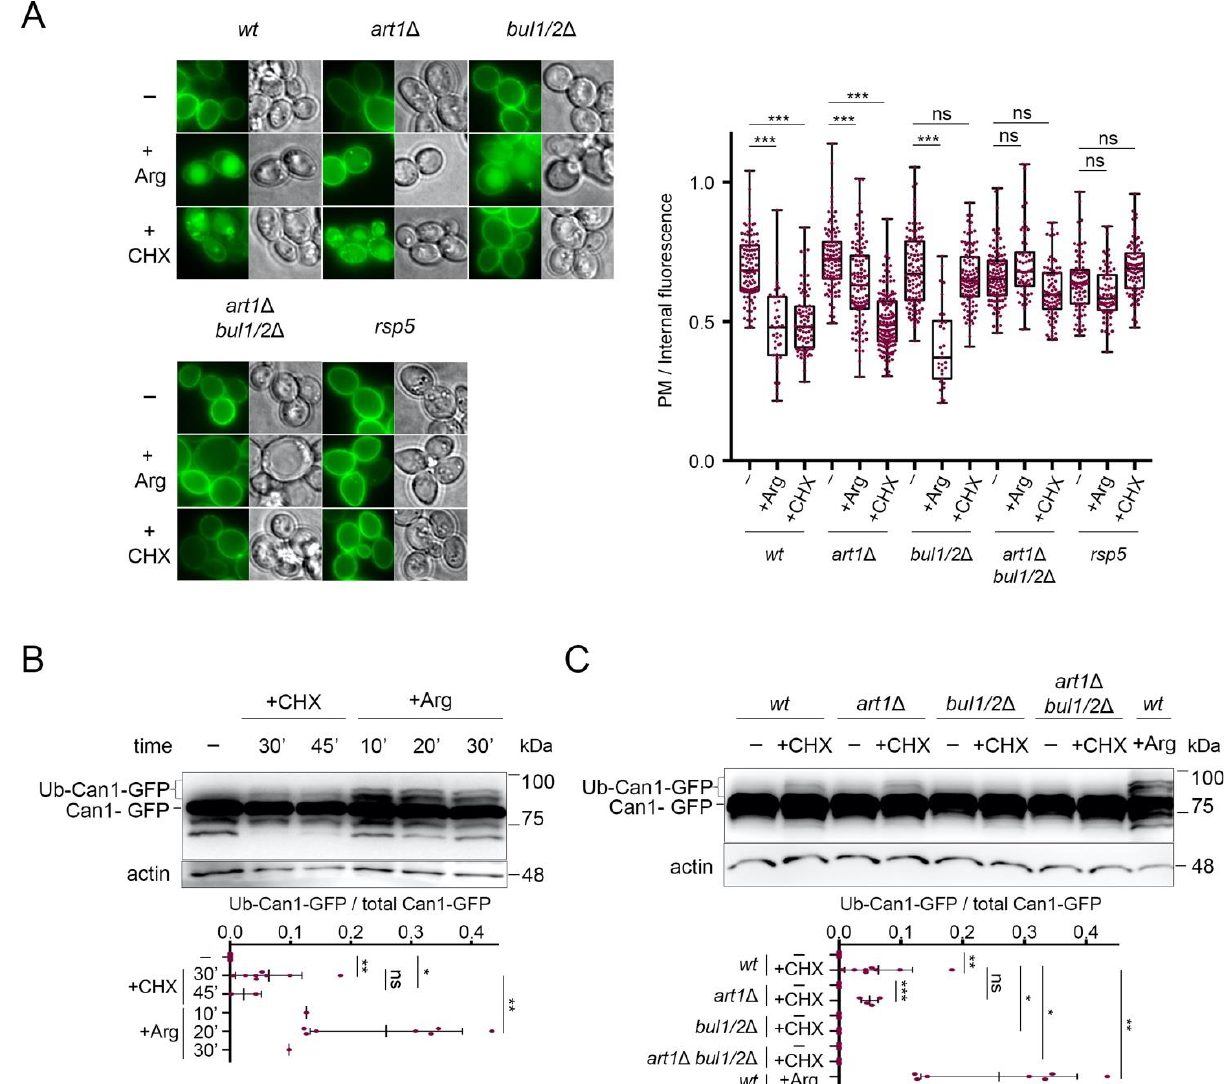
Figure 2. Can1 endocytosis in CHX-treated cells requires the Bul1/2 alpha-arrestins. ( A ) Epifluorescence microscopy of Can1-GFP in wt, bul1/2 Δ, art1 Δ, art1 Δ bul1/2 Δ , and npi1-1 strains. Strains were grown on Minimal Medium (MM) with Galactose (Gal) and Ammonium (Am). GAL1-promoter-driven expression of CAN1-GFP was repressed by addition of 3% Glucose (Glu) for 1 h. Arg (5 mM) or CHX (50 µ g/mL) were then added for 3 h. Quantifications: plasma membrane (PM) to internal GFP fluorescence intensity ratios, are plotted ( n = 31–135 cells) as box and whiskers plots. The horizontal midlines represent the median values, the boxes are bounded by the upper and lower quartiles, and the whiskers denote the maximal and minimal ratios. Red dots represent the individual values. ***, p < 0.001; ns, nonsignificant, p > 0.05. Scale bar is 2 μm. ( B ) Wt strain expressing Can1-GFP was grown on Gal, Am MM. Glu was added for 30 min, a non-treated sample was collected (-) and then CHX was added for 30 or 45 min or Arg for 10-, 20- or 30-min. Total protein extracts were probed with antibodies against GFP and actin. The low mobility bands correspond to Ub-Can1-GFP conjugates. Quantifications: The ratio of Ub-Can1-GFP / Total Can1-GFP are plotted in scattered plots. Red dots represent the individual biological replicates. ***, p < 0.001; **, 0.001< p < 0.01; *0.01 < p < 0.05; ns, nonsignificant, p > 0.05. Lower exposure is provided in supporting information. ( C ) The indicated strains expressing Can1-GFP were grown on Gal, Am MM. Glu was added for 30 min, a non-treated sample was collected (-) and then CHX was added for 30 min or Arg for 20 min. Protein extracts were probed and analysed as in B. Lower exposure is provided in supporting information.